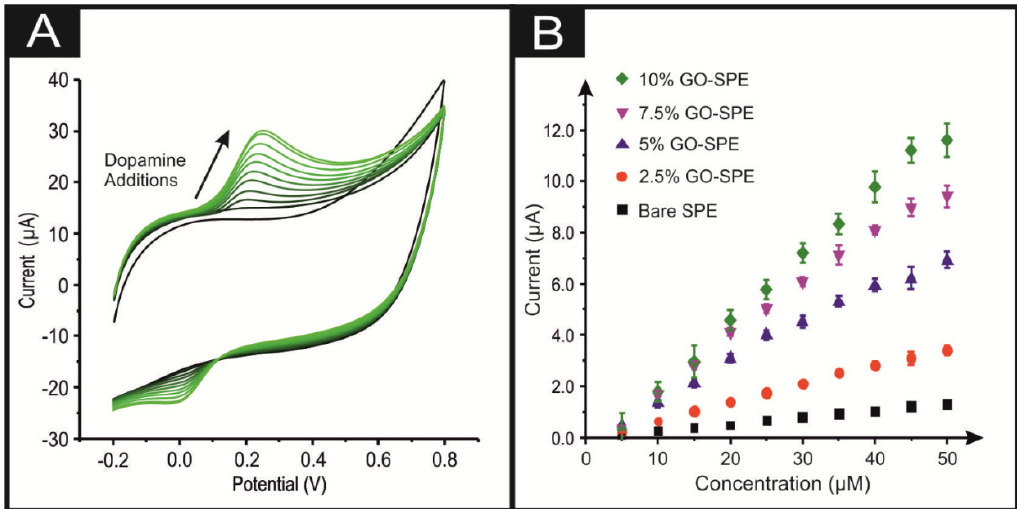
Figure 2. (A) Typical cyclic voltammetric response obtained utilising 10% GO-SPEs by sequentially adding aliquots of DA into pH 7.4 PBS, from 5 to 50 µM. (B) Calibration plot of the anodic peak current associated with the electroanalytical oxidation of DA over the concentration range for a bare SPE (black square), a 2.5% GO-SPE (orange circle), a 5% GO-SPE (blue triangle), a 7.5% GO-SPE (purple inverted triangle), and a 10% GO-SPE (green star). Error bars are on the data points and represent the average standard deviation ( N = 3). Scan rate utilised: 100 mVs –1 (vs. SCE ).